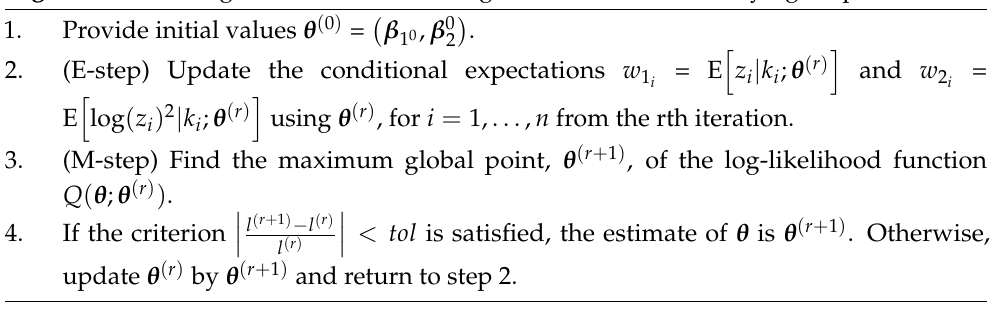
Algorithm 1 EM Algorithm for the PLN Regression Model with Varying